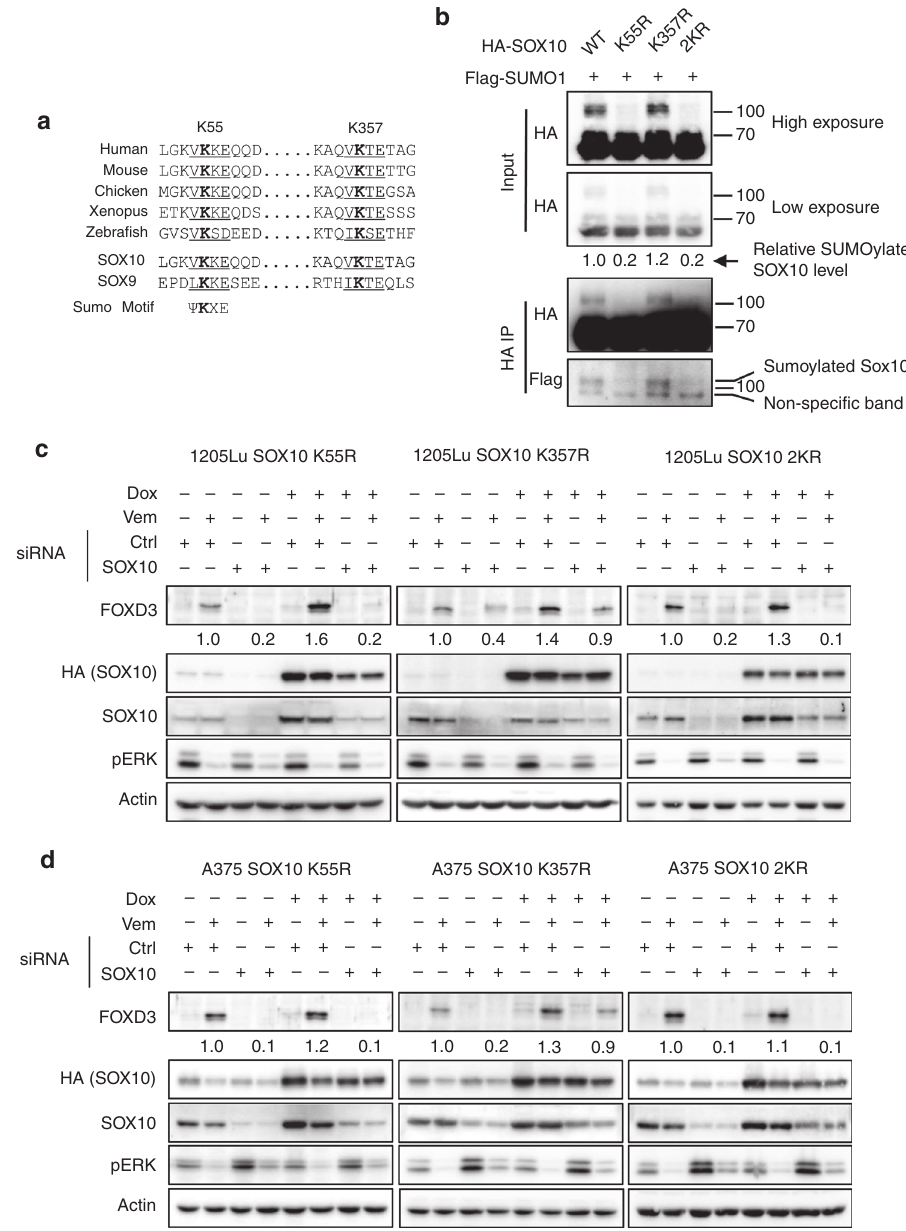
Fig. 5 K55 sumoylation is essential for the transcriptional activity of SOX10 toward FOXD3. a Alignment of sumoylation motifs in SOX10 from different species and SOX9. Putative sumoylation sites were underlined and consensus sumoylation motif is shown. b HEK293T cells were co-transfected with plasmids expressing Flag-SUMO1 and one of the HA-SOX10 variants including WT, K55R, K357R, and 2KR. After 48 h, immunoprecipitation was performed with HA-tag antibody. Inputs and immunoprecipitates were analyzed by western blot. Relative levels of SOX10 sumoylation were quantitated by normalizing the intensities of the sumoylated bands against the non-sumoylated bands. c 1205Lu-TR cells transduced with lentiviruses carrying siRNA- resistant HA-SOX10 cDNA variants including K55R, K357R, and 2KR were transfected with SOX10 siRNAs for 72 h in the absence or presence of 100 ng ml − 1 doxycycline. Cells were then lysed and analyzed by western blot on indicated proteins. Actin was used as a loading control. Quantitation of FOXD3 expression is shown below the corresponding blots. d Same as ( b ) except that A375-TR cells were used. Uncropped images are shown in